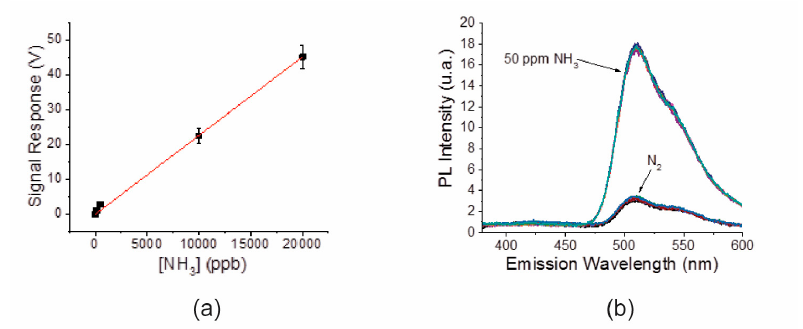
Figure 1. ( a ) Optical response of the fluorescein emission peak to five difference ammonia concentrations. The results were fitted to the equation: (cid:1877) = 0.0026 ∙ (cid:1876) (R 2 = 0.999); ( b ) Ammonia sensor reversibility through six different N 2 /NH 3 cycles [NH 3 ] = 50